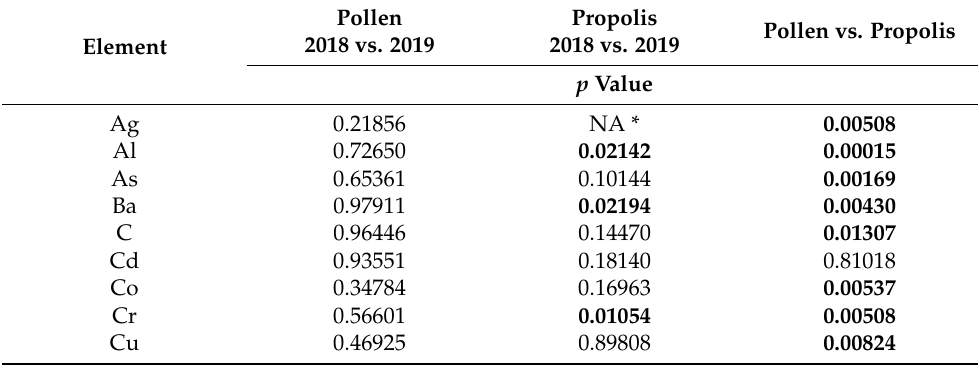
Table 3. Results of univariate tests performed to compare levels of chemical elements ( n = 24) in two beehive products collected over two years from the same area: bee pollen and propolis. Bold text indicates a statistically significant difference with a p -value below